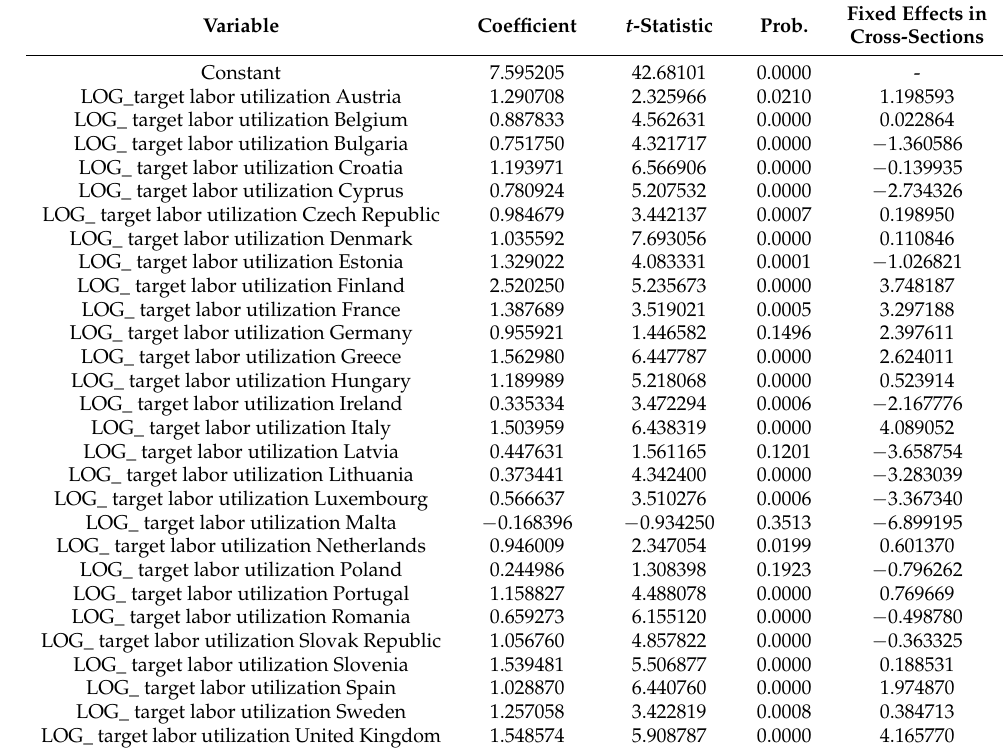
Table 3. Fixed effects model to explain the GHG emissions based on target labor utilization in the EU-28 countries